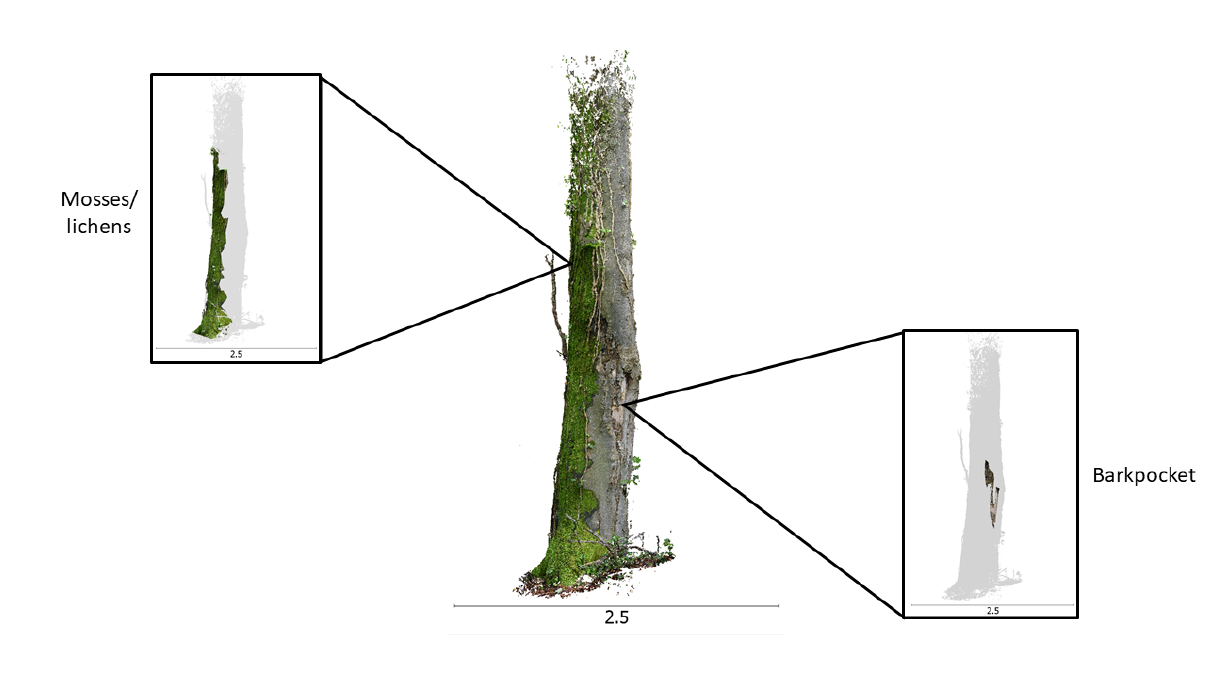
Figure 7. Different layers visible in VR for facilitating TreMs identification. Scale bar unit are in